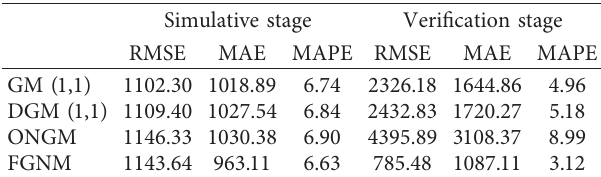
Table 3: Raw data on natural gas consumption of China from 2005 Table 5: Comparison of prediction accuracies generated by these four